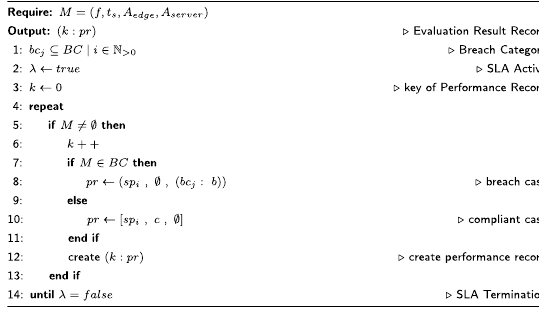
Algorithm 2 Evaluation of Received Monitoring